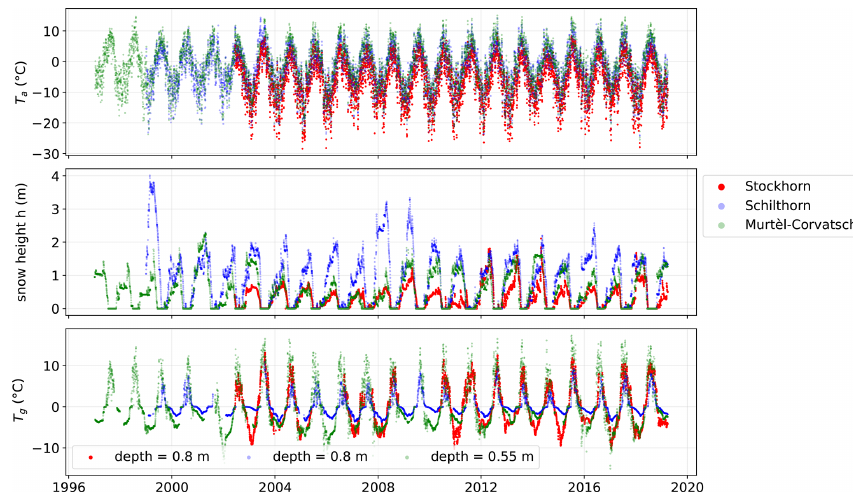
Figure 2. Air temperatures, snow height and ground temperatures for all three stations.